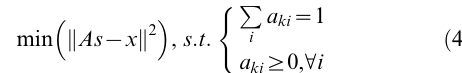
Figure S1 Condition number of signature basis matrix varies with number of probesets included. (a) Function of the condition number vs . the number of probesets from the gene signature was characterized in blood and breast mixture cell lines.